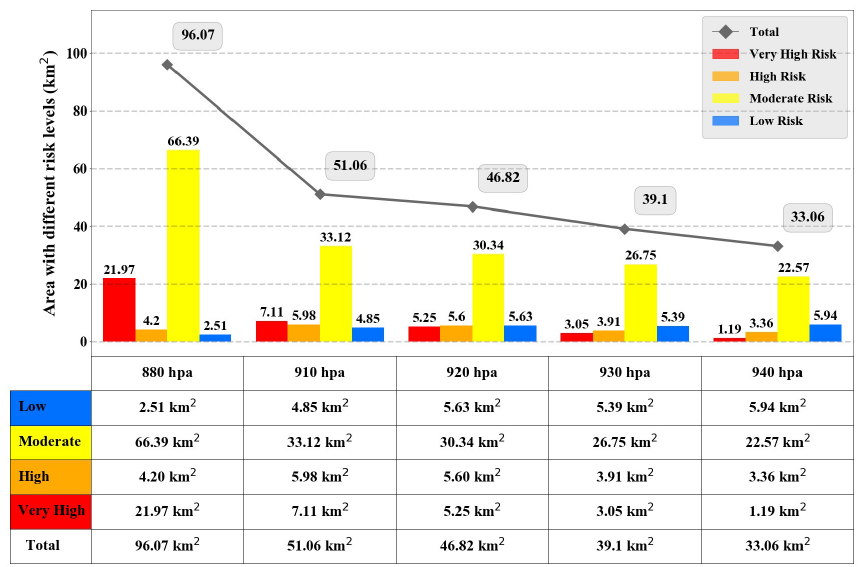
Figure 20. The areas of different risk level zones for each of the designed typhoon scenarios (880, 910, 920, 930, 940hPa).